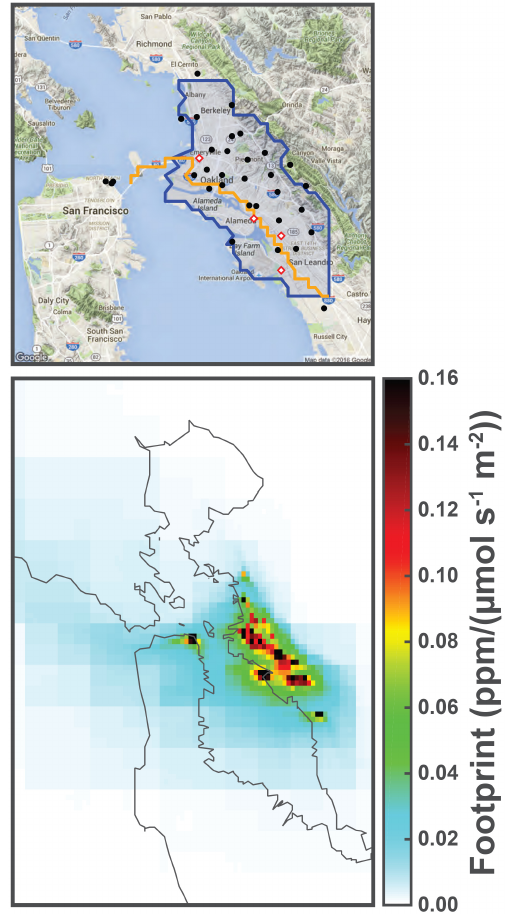
Figure 2. Top panel shows the location of the sites (black circles), the area source (blue region), the line source (orange line), and point sources (red diamonds). Bottom panel shows the 15 to 22 Septem- ber average footprint for the 34 sites in the network; see Table 1 for a list of the sites. The bottom panel is the full domain used for the inversion. Supplement Fig. S3 shows the footprint on a log